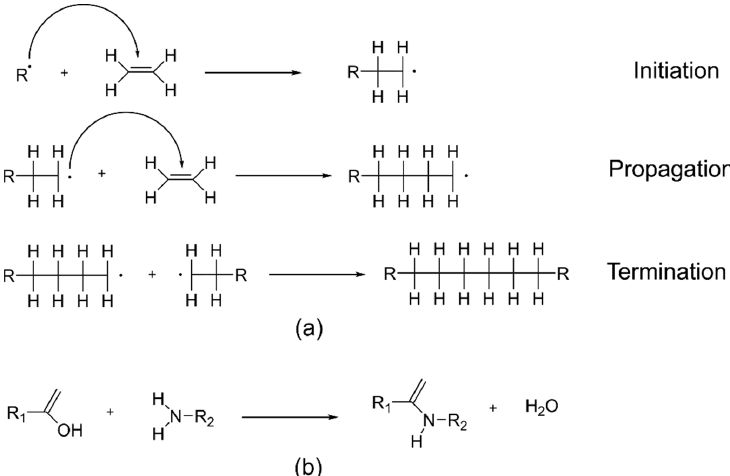
Figure 3. Reactions for the formation of ( a ) addition polymers (showing radical polymerization with one of the possible termination steps); and ( b ) condensation polymers. R · represents a free radical, while R 1 and R 2 represent two different organic groups.